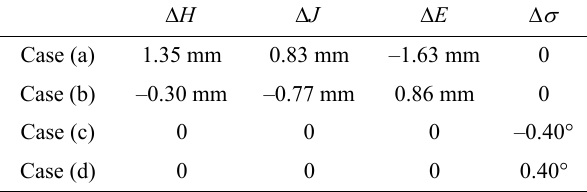
Table 3 Four representative misalignment combinations.